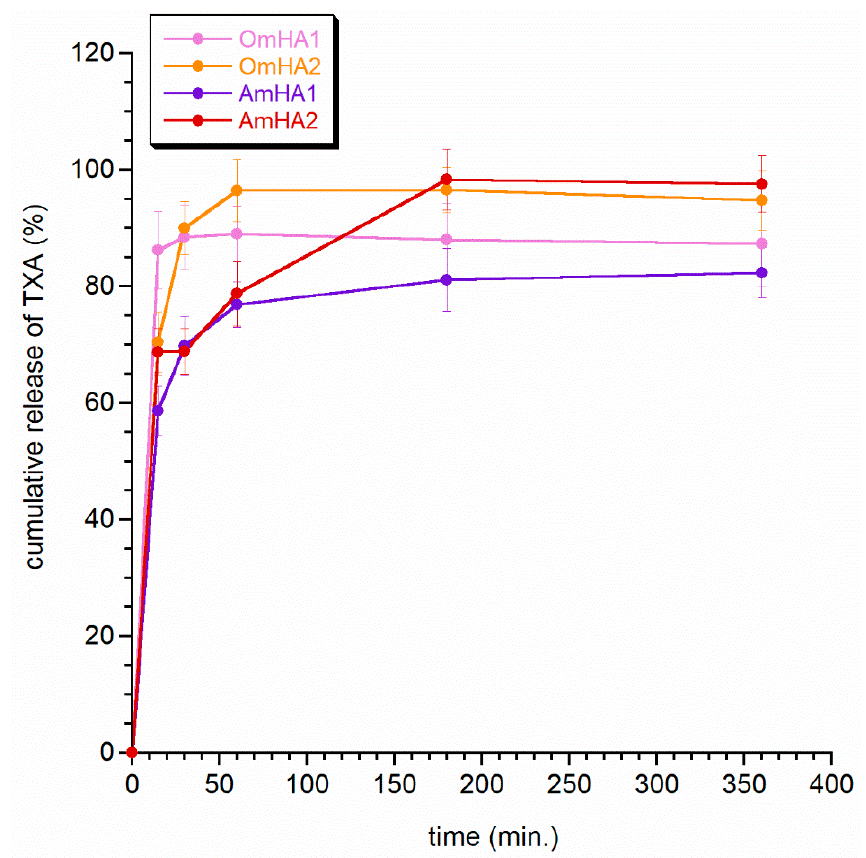
Figure 4. TXA release profiles from the obtained composites.